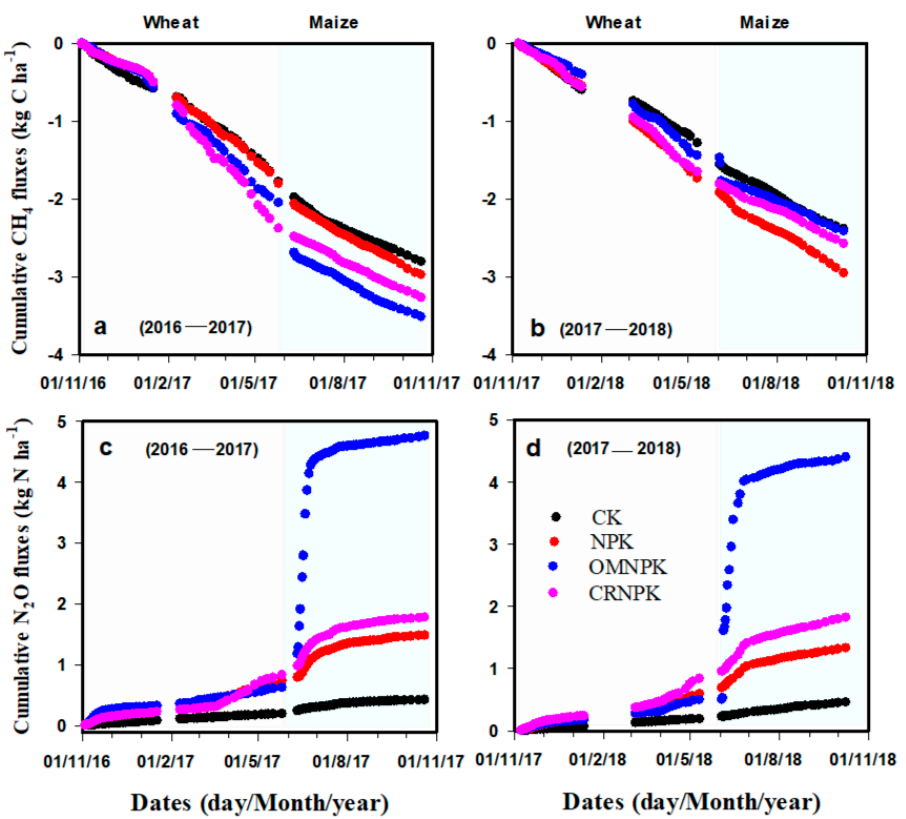
Figure 3. Seasonal and annual cumulative CH 4 fluxes ( a , b ) and cumulative N 2 O fluxes ( c , d ) in the wheat-maize rotations for the four treatments over the two-year period from 2016–2018. Each colored circle point in the panels indicates the mean for measured data for three spatial replicates ( n = 3) with error bars not